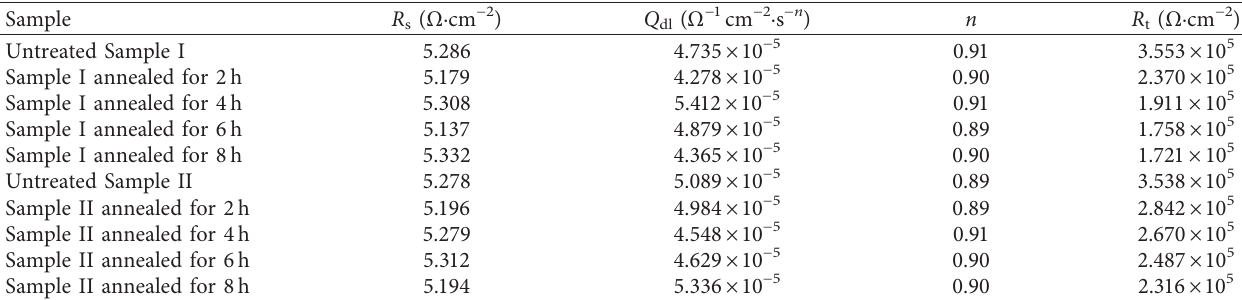
Figure 4: Equivalent electrical circuit for fitting the EIS Table 3: Equivalent electrical circuit parameter fitted results.